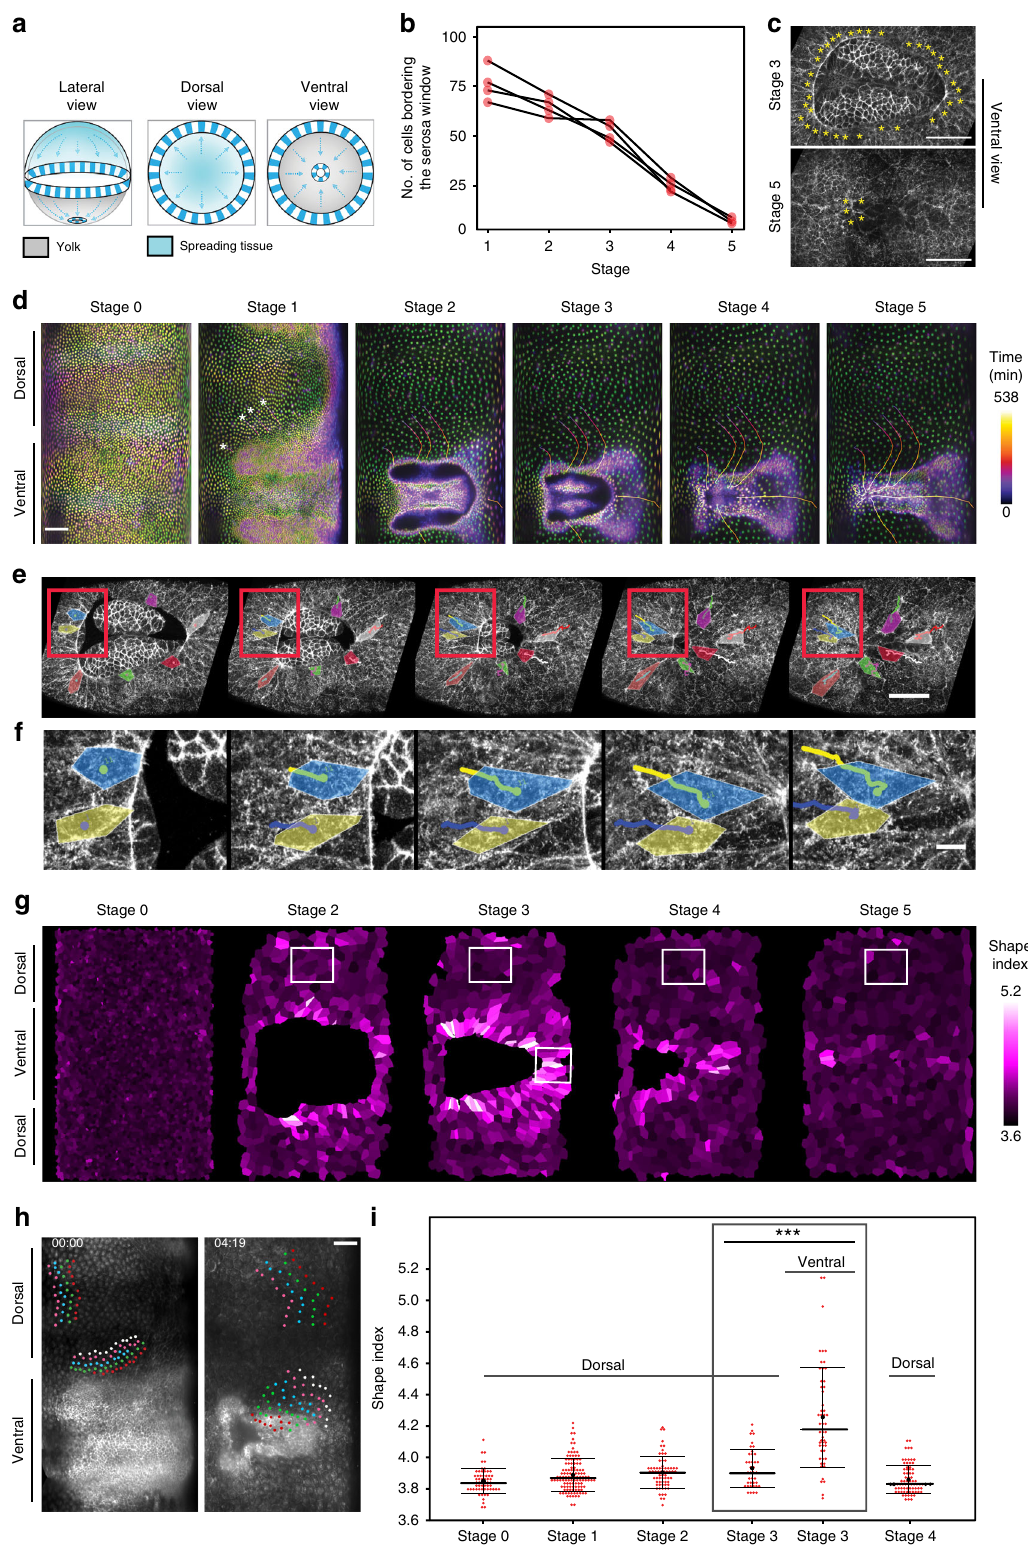
shapes (Supplementary Fig. 3A and Supplementary Movie 11), and frequently exchanged neighbors (Fig. 2h and Supplementary Movie